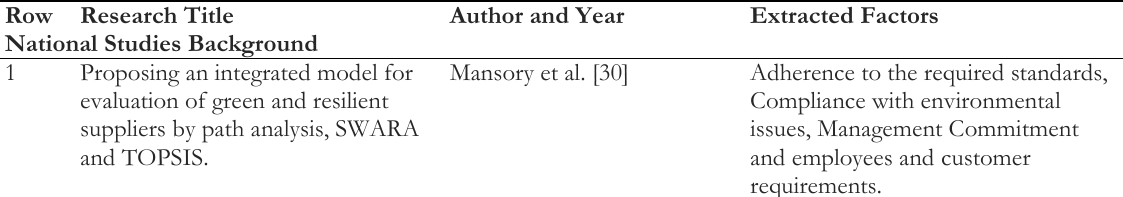
Table 1. Research